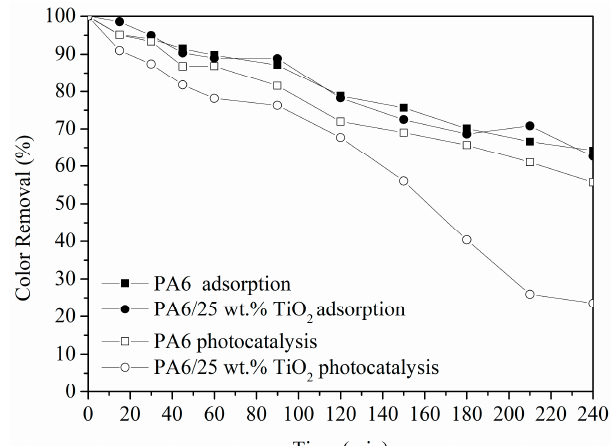
Figure 4. Colour removal of Remazol Black B solution at 597 nm during the contact with PA6 and PA6/25 wt.% TiO 2 nanoparticles electrospun nanofiber membranes with and without UV light.